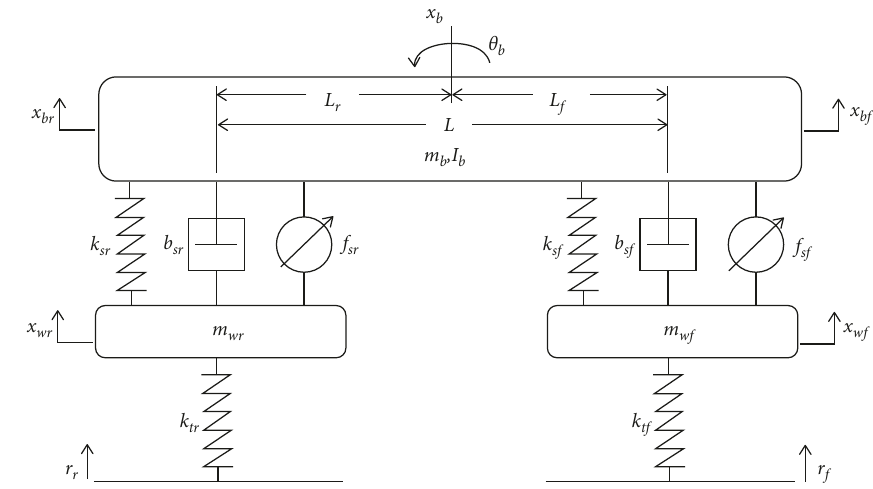
Figure 1: Half-car model of the active